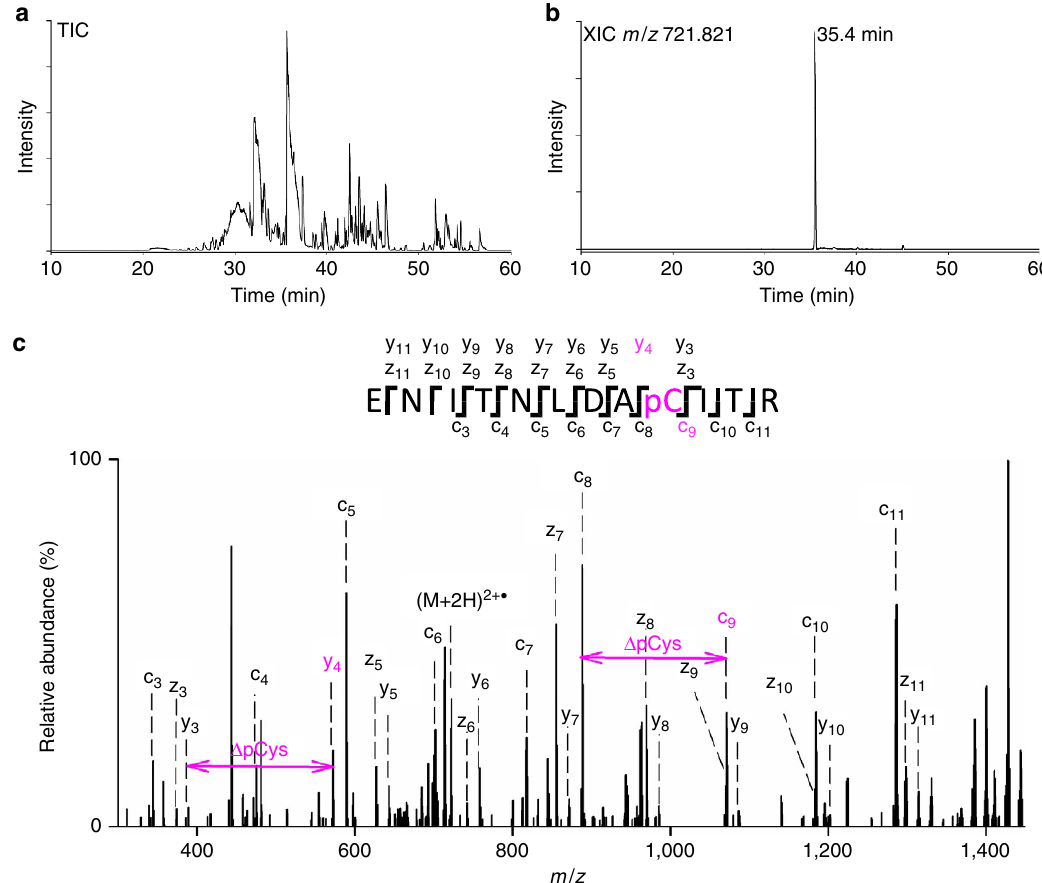
Figure 5 | Analysis by nLC-ESI-EThcD MS/MS of the endogenous pCys peptide. ( a ) Total ion chromatogram (TIC) of the tryptic digestion after in vitro phosphorylation. ( b ) Extracted ion chromatogram (XIC) of the phosphorylated Cys peptide with m/z 721.821. ( c ) EThcD MS/MS spectra of the endogenous pCys peptide, ENITNLDApCITR, showing complete sequence coverage and diagnostic fragment ions c9, y4 and